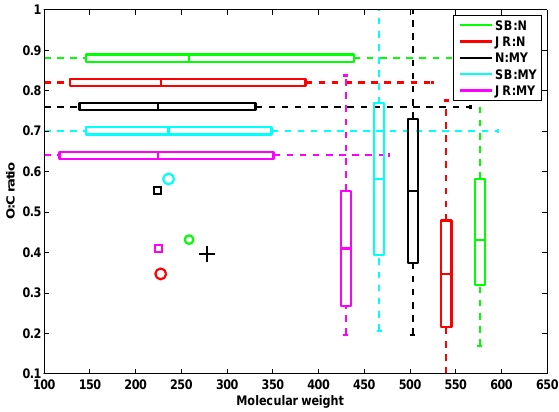
Fig. 10. The distribution of the average O:C ratios and M w s of the predicted condensed mass across all conditions and 1000 initialisa- tions, with the box-and-whiskers showing the median, interquartile and 95% ranges for each combination of estimation techniques; the cross indicates the average composition from the base-case tech- nique and the coloured open symbols show the average predicted using the other technique. On average the M w of secondary organic mass is lower using techniques using JR, consistent with overpre- diction of T b and lower molar mass compounds becoming too con- densable. The correction applied to the JR yielding the SB tech- nique leads to more similar average O:C ratio and M w to the base case method. The methods employing MY also predict average M w lower than the base case but higher average O:C ratio. A higher de- gree of oxygenation is therefore required on average across all ini- tialisations using these methods for the molecules to be sufficiently involatile to